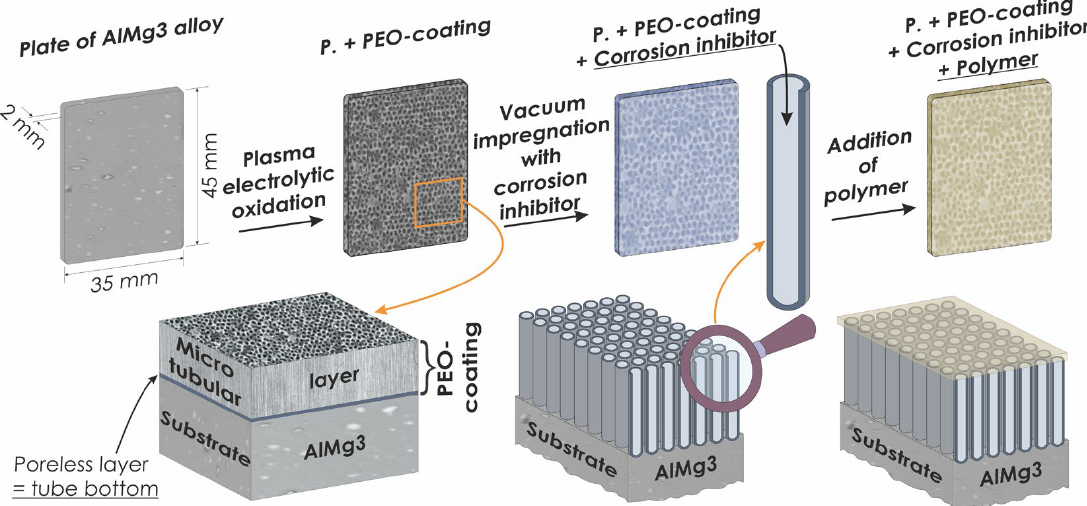
Figure 1. Stages of formation of composite and hybrid coatings .